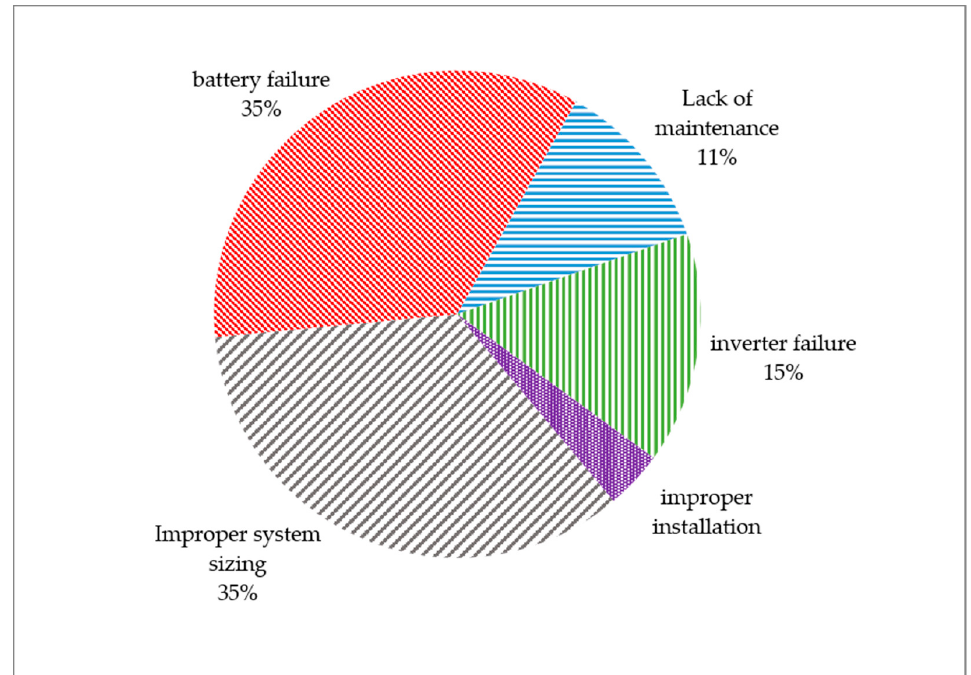
Figure 7. Main reasons for unreliable solar PV electricity access.